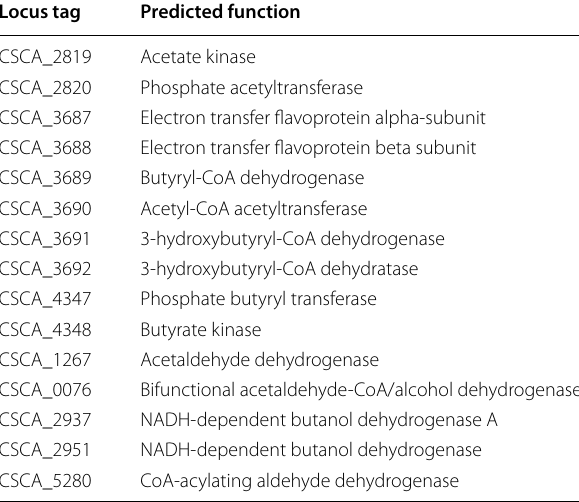
Table 2 Genes predicted to be involved in Wood–Ljun- gdahl pathway of C. scatologenes ATCC 25775 Locus